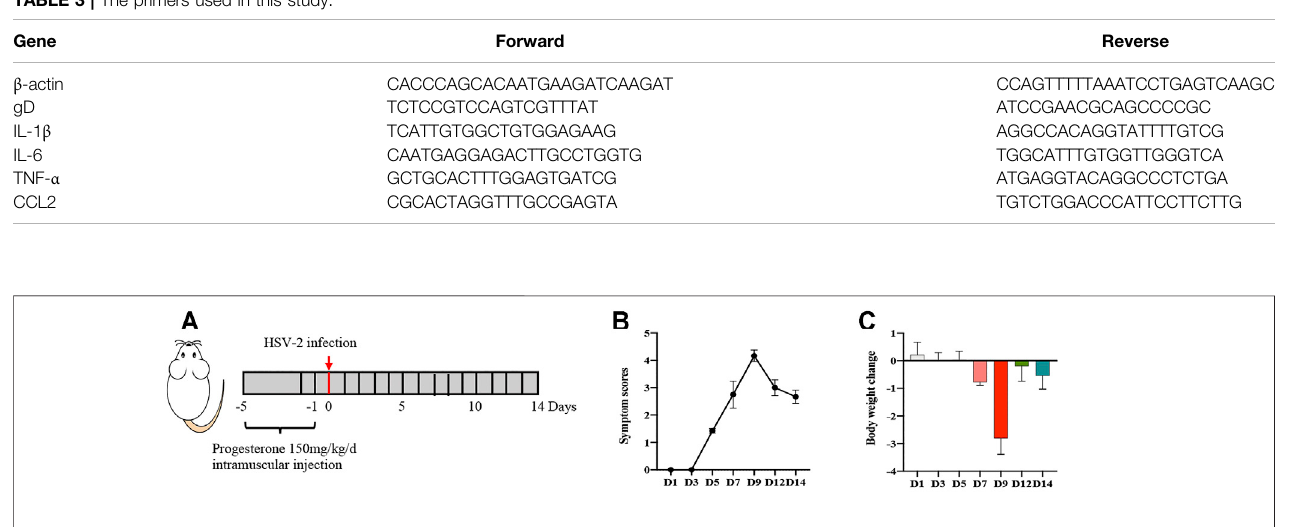
Frontiers in Pharmacology |